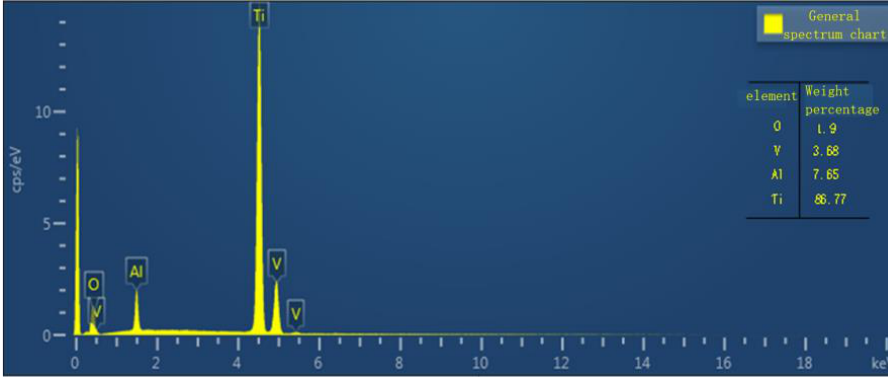
Figure 18. Surface composition of the workpiece after acid etching.